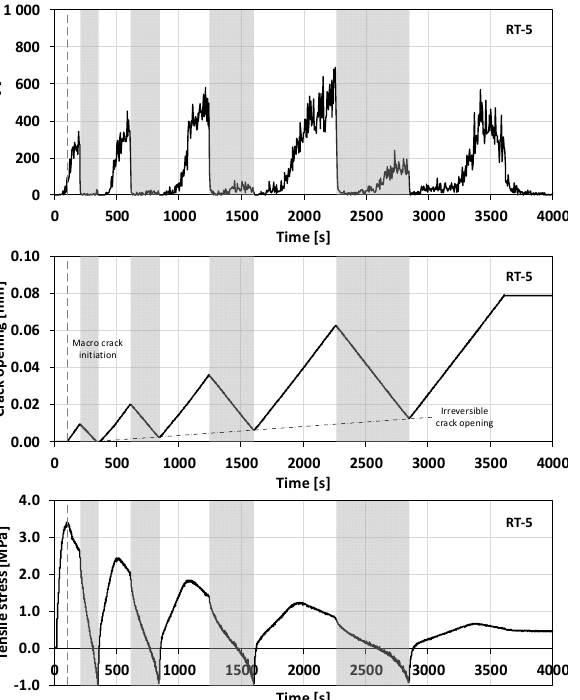
Figure 11. Cyclic tensile test results summarized as Hit ‐ time relation (upper), Crack opening ‐ time relation (middle) and Stress ‐ time relation (lower) for R50T ‐